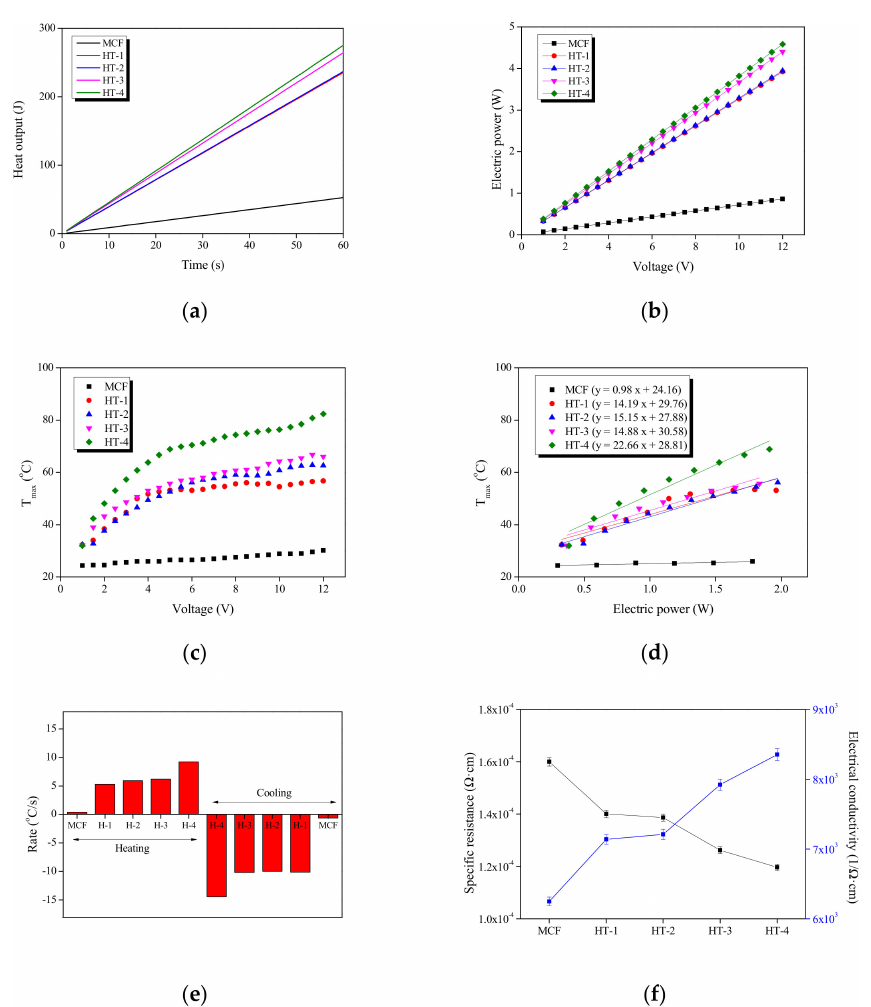
Figure 6. Thermal and electrical properties of MCF as a function of heat treatment time: ( a ) heat output, ( b ) electric power-voltage curves, ( c ) applied voltage changes of T max , ( d ) electric power changes of T max , ( e ) heating / cooling rate, and ( f ) electrical